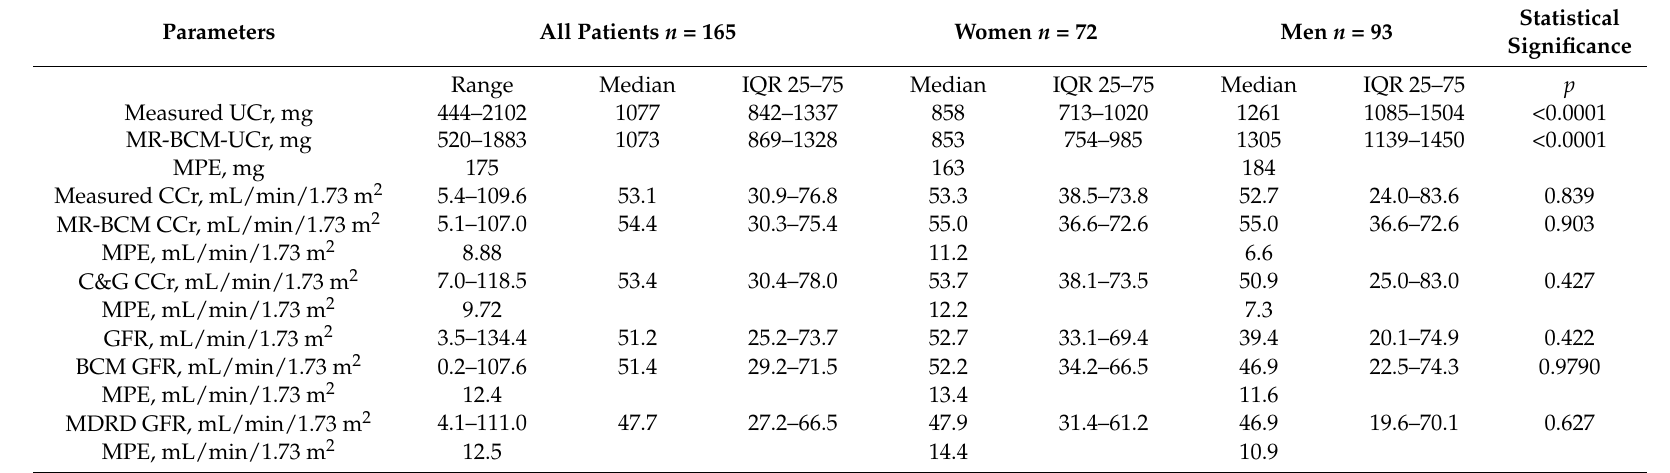
Table 3. Predicted and measured values of urinary creatinine excretion (UCr), creatinine clearance (CCr) and the glomerular filtration rate (GFR), and mean prediction errors (MPE). MR-BCM CCr (prediction from multiple regression analysis and body cell mass), C&G CCr (Cockcroft–Gault formula), MDRD GFR (prediction of GFR from the Modification of Diet in Renal Disease formula) Median values and interquartile ranges (IQR 25–75) are reported separately for women and men. The statistical significance of the difference between women and men is